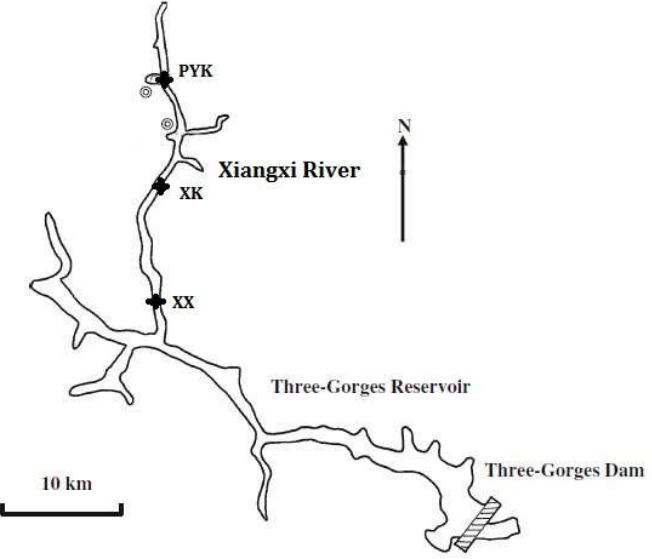
Figure 1. Sketch map of the sample stations in the Xiangxi River (three sample stations: XX, XK and PYK, located at the upstream, midstream and